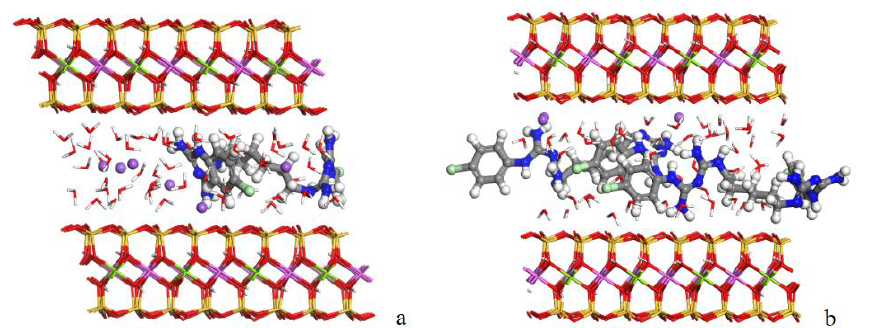
Figure 11. Complexes with one ( a ) and two ( b ) molecules of CHX drug adsorbed in the interlayer space of the BEN. The atoms of silicon, aluminum, magnesium, oxygen, hydrogen, carbon, nitrogen, chlorine and sodium are presented in yellow, pink, green, red, white, grey, blue, light green and purple, respectively.